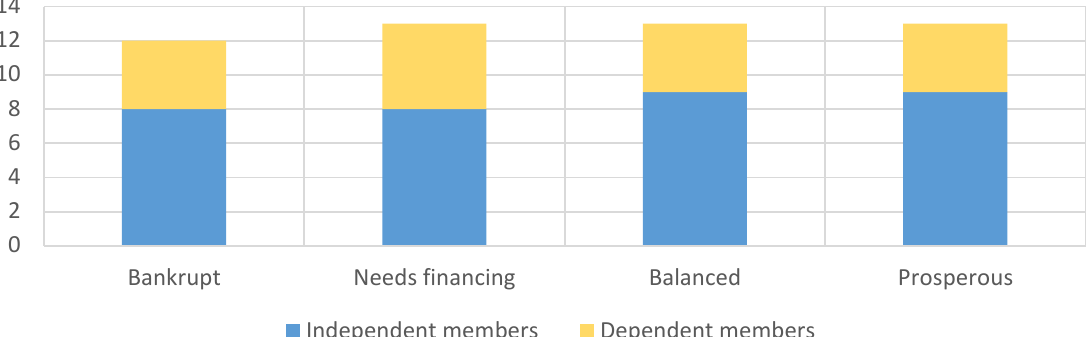
Figure 2. Dependent and independent board members for each of the four states